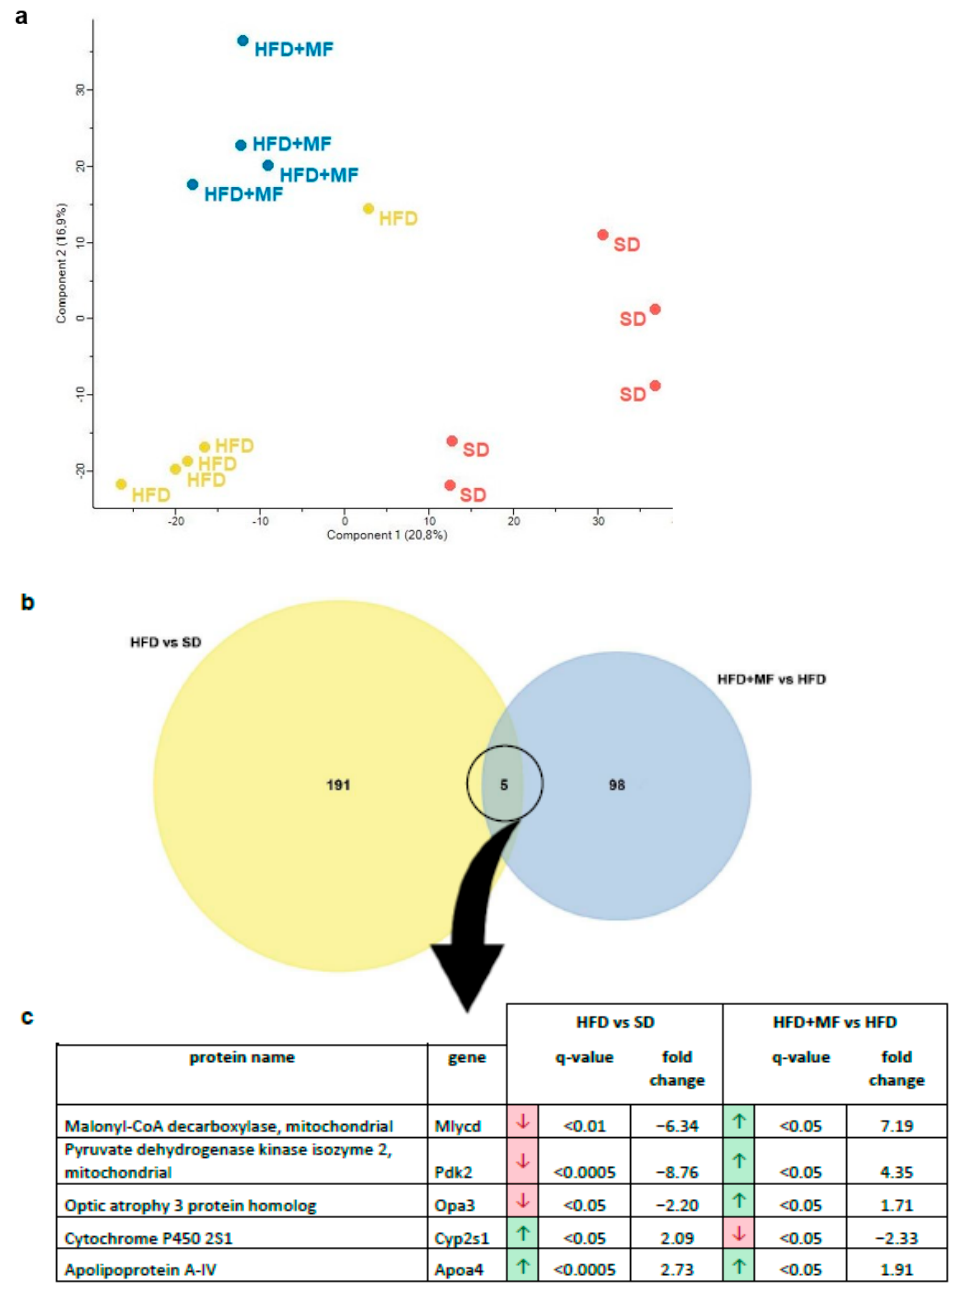
Figure 2. Proteins were extracted from pgWAT, detected by mass spectrometry and identified using MaxQuant software. Further data analysis was carried out with Perseus software. ( a ) A principal component analysis of all detected proteins was performed to visualise differential global protein expression. ( b ) A Venn diagram of significantly (fold change > 1.5, q-value < 0.05) and relevantly altered (full or 0 valid values per group) proteins to illustrate overlaps in comparison of HFD vs. SD (i.e., the number of proteins altered in pgWAT by HFD feeding) and HFD + MF vs. HFD (i.e., the number of proteins altered in pgWAT of HFD dams by metformin treatment during pregnancy). ( c ) The five overlapping proteins of both comparisons with their protein name, gene name, regulation, q-value and fold change. The arrows indicate either a downregulation (red) or upregulation (green) in obese (HFD) compared to lean dams (SD) (comparison 1—HFD vs. SD) or in metformin-treated HFD dams (HFD + MF) compared to obese dams without treatment (HFD) (comparison 2—HFD +